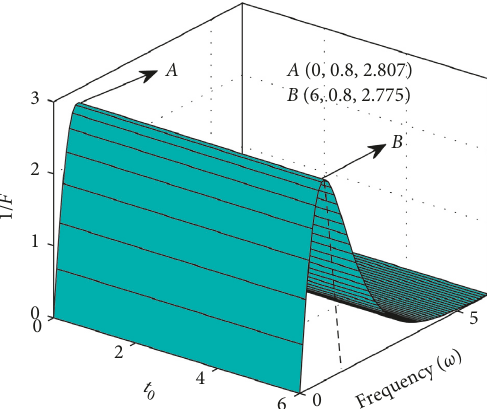
Figure 2: Effect of t 0 on the chaos